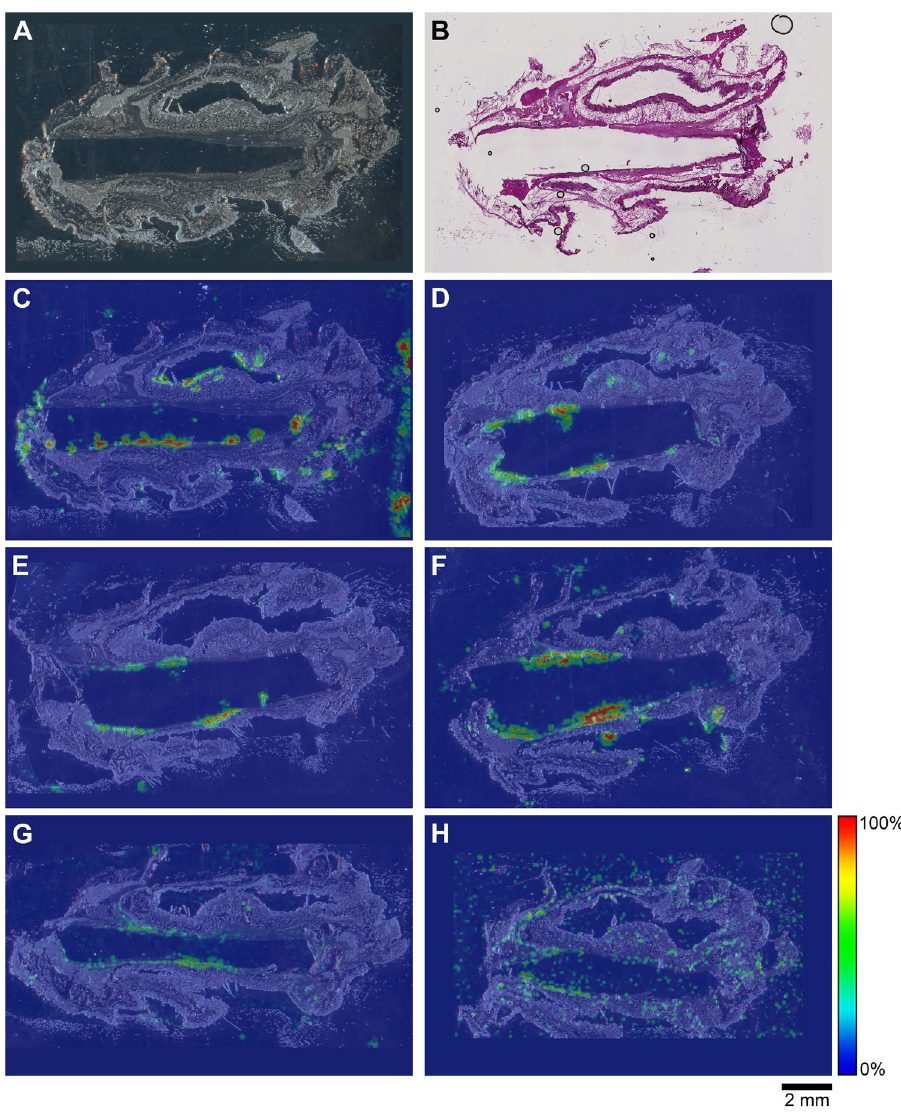
Figure 10. Representative TAF and drug metabolite spatial distribution profiles in mouse dermal tissue sections adjacent to low-releasing (0.23 mg d -1 ) TAF implants, with the implants remaining in situ within the encasing tissue block excised at necropsy, on study Day 14. ( A ) Light microscopy image of the tissue section. ( B ) H&E Serial section stain of matching tissue specimen. ( C – H ) Overlay of mass spectrometry images, generated at a spatial resolution of 100 µm, and light microscopy images of the tissue specimens. ( C ) TAF; ( D ) Metabolite X; ( E ) Metabolite Y; ( F ) TFV; ( G ) TFV-MP; and ( H ) TFV-DP. Color key in the legend indicates relative ion abundance, with red representing the highest signal intensity (100%) and blue representing the lowest signal (0%) for the corresponding measured ion; all images were scaled individually. Scale bar, 2